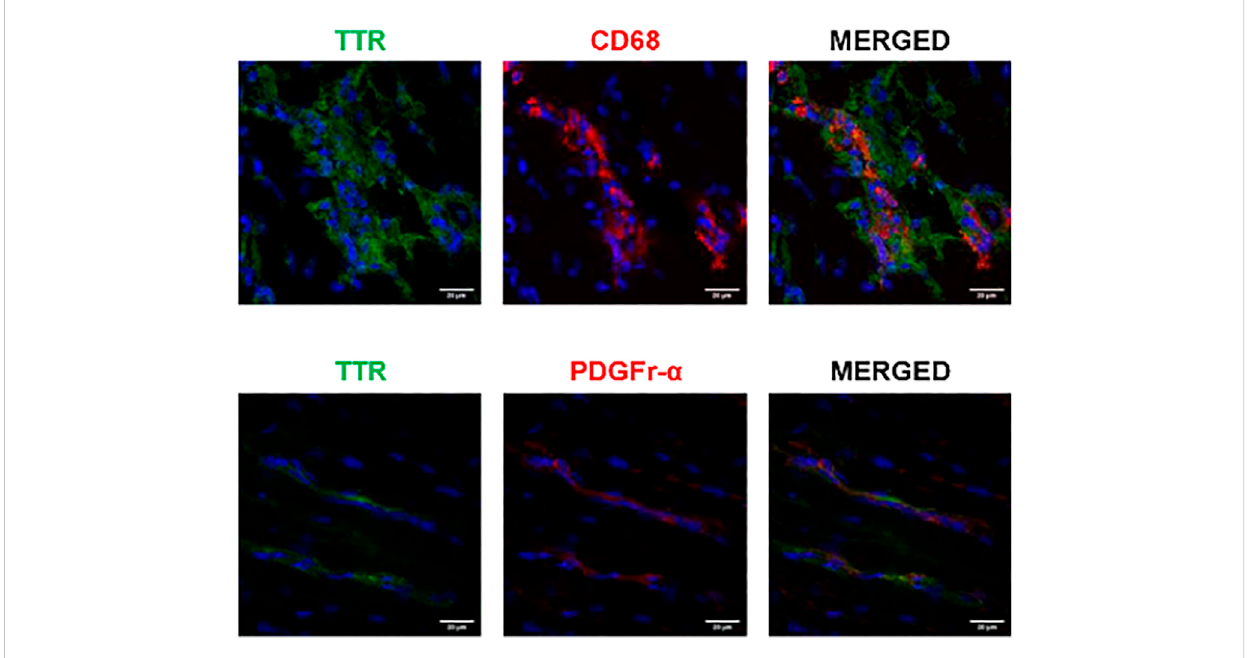
FIGURE 3 Possible TTRuptakebymacrophages.Confocal microscopy offrozenheartsections ofHSF ± hTTRV30Mmice. Macrophage(CD68)presencewas more prevalent in TTR deposited sites whereas there is no clear internalization of TTR by cardiac fi broblasts, here stained with PDGFr-alpha. Nuclei are stained blue with DAPI. Scale bars, 20